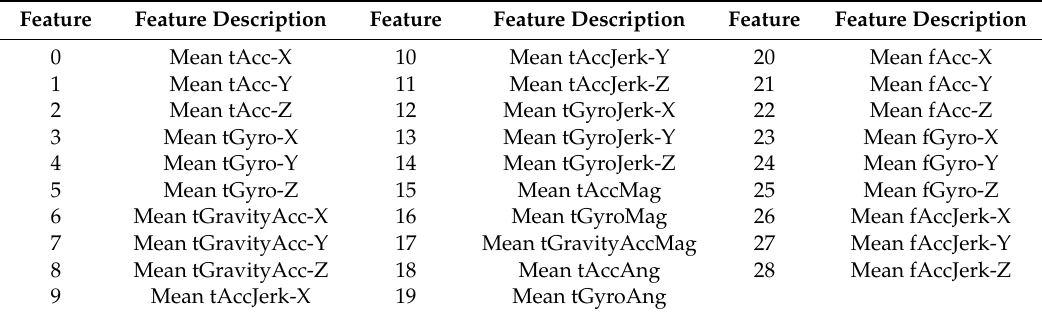
Table 3. Processing method corresponding to Arithmetic-mean.